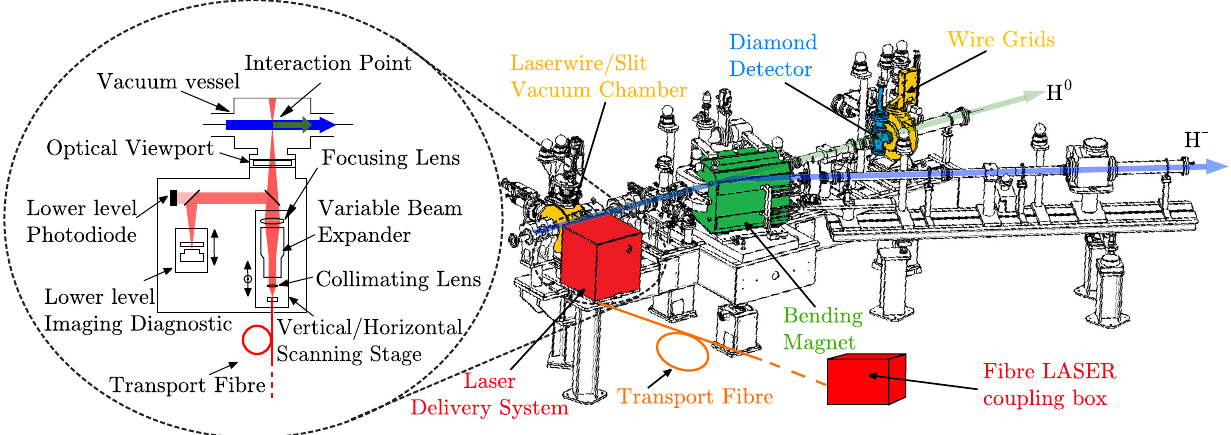
FIG. 5. Layout of the 3 MeV diagnostics test bench as it was installed after the Chopper, including the operational emittance meter (slit and grids) and the laserwire emittance scanner prototype.